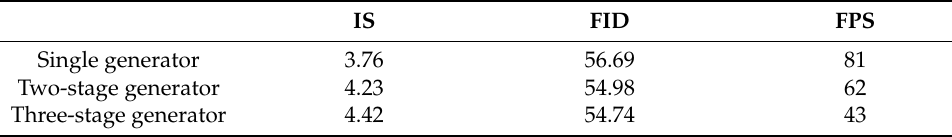
Table 6. A comparison of the validity of generator networks.